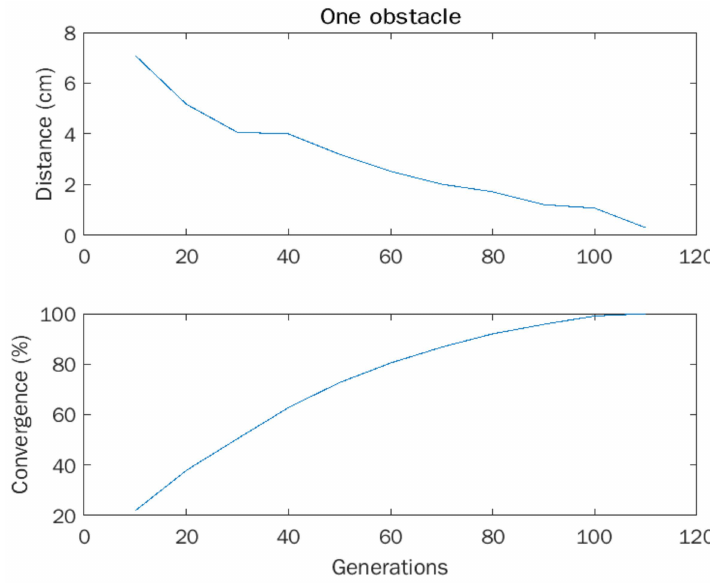
Figure 10. Results of experiment 1.